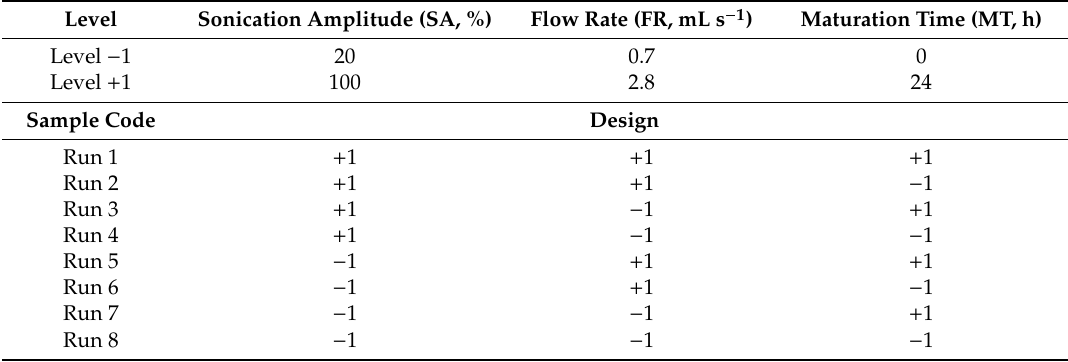
Table 1. Levels of factors and 2 3 experimental design matrix applied for the synthesis of calcium phosphate nanoparticles (CaP